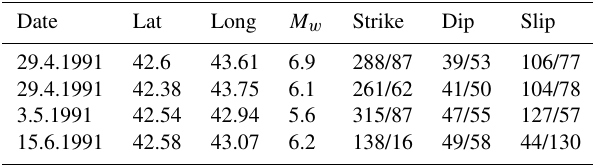
Table 1. Data from Global CMT